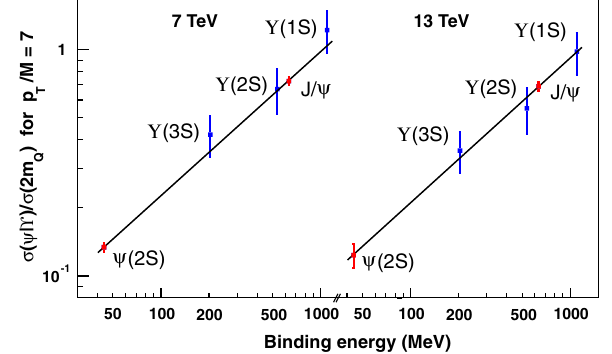
Fig. 5 Correlation between the long-distance factor σ( Q )/σ( 2 m Q ) and the quarkonium binding energy, at 7 and 13TeV